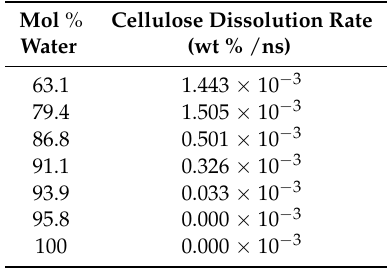
Figure A6. TBPCl–water small cellulose bundles dissolution measured by the number of dissolved glycans at 360K. Table A1. Small cellulose bundle dissolution rates